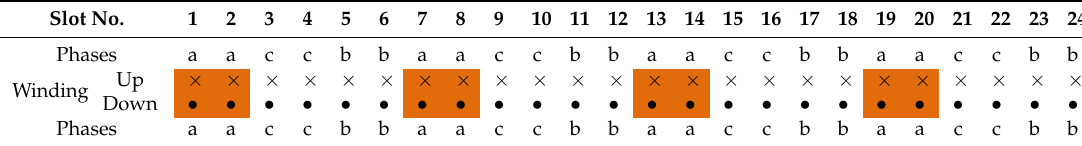
Table 3. Winding configuration for the N-TWDDPMSM.